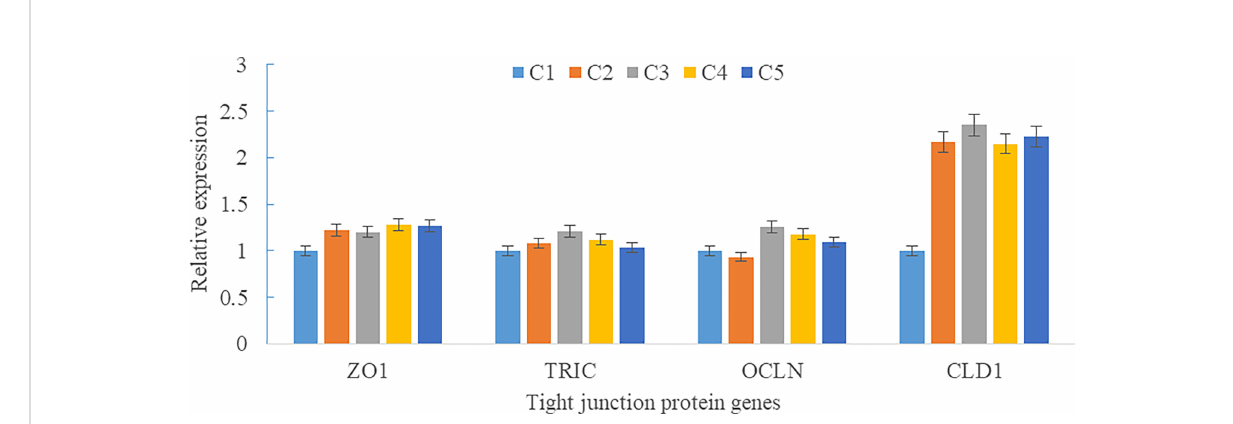
FIGURE 6 Effects of fi shmeal replacement by cottonseed protein concentrate on the mRNA expression levels of tight junction protein genes in intestine of rainbow trout (Mean ± S.E.). Different letters on the bar chart indicate signi fi cant difference ( P < 0.05).